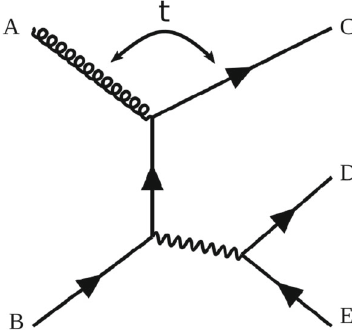
Fig. 1 The Compton scattering diagram of the NLO Drell–Yan pro- cess: gluon A and quark B are the initial particles, resulting in a quark C and a photon, which in turn splits into a pair of leptons D and E. This diagram has a divergence in the t channel and it is the most relevant one at NLO for small x due to the gluon distribution